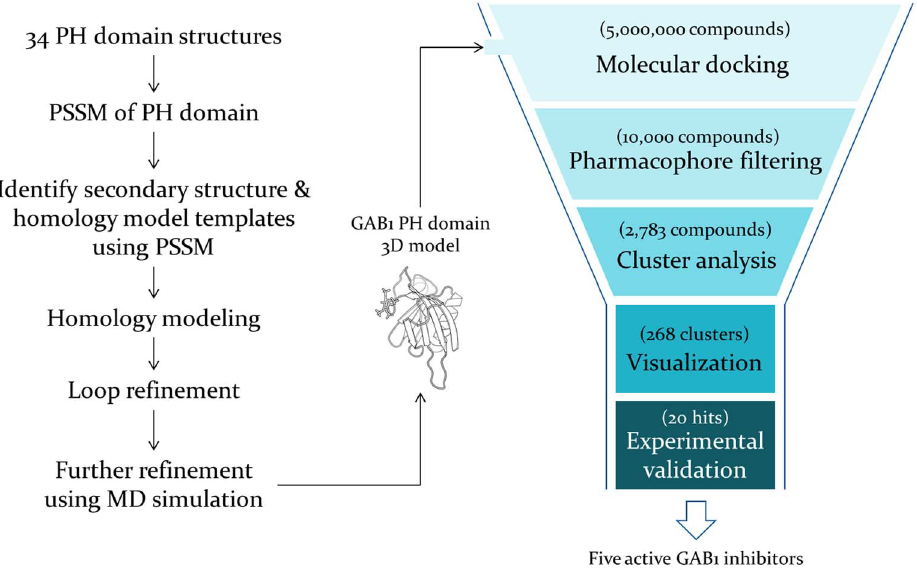
Fig. 1. Structure-based drug discovery workflow. All of the available PH domain 3D structures in the PDB were used to build our PSSM scoring functions which were employed to construct the homology model of GAB1 PH domain. The derived structure was used to perform high-throughput virtual screening of five million drug/lead-like compounds. Through a funnel-like process 20 hits were selected for experimental testing and five were confirmed as consistently active in all of the assays.